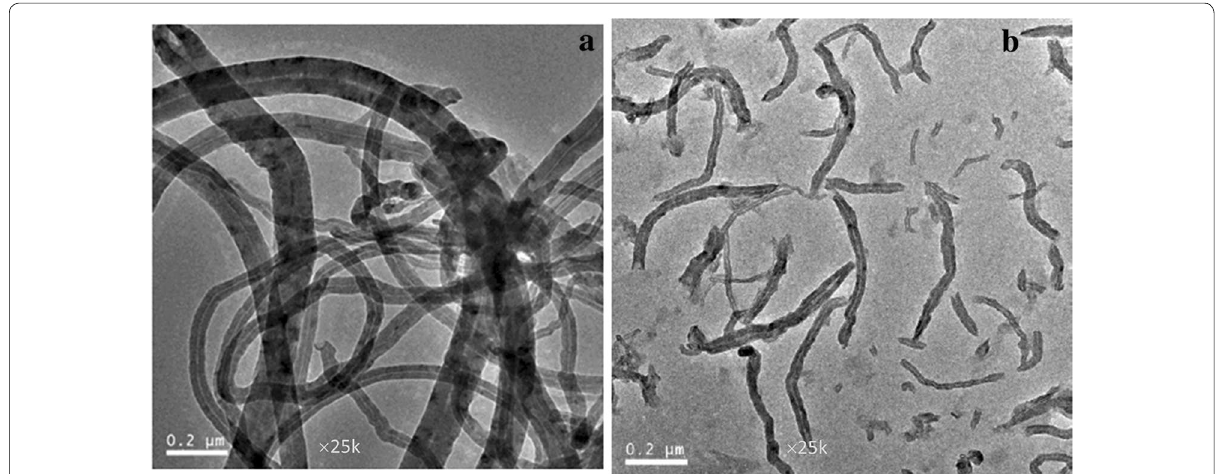
Fig. 1 The TEM image of CNTs: a before the dispersion; b after the dispersion.